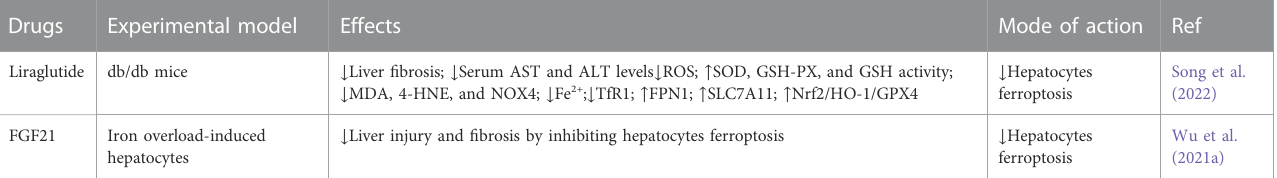
TABLE 2 Compounds alleviate liver fi brosis through inhibiting ferroptosis in hepatocytes. Drugs Experimental